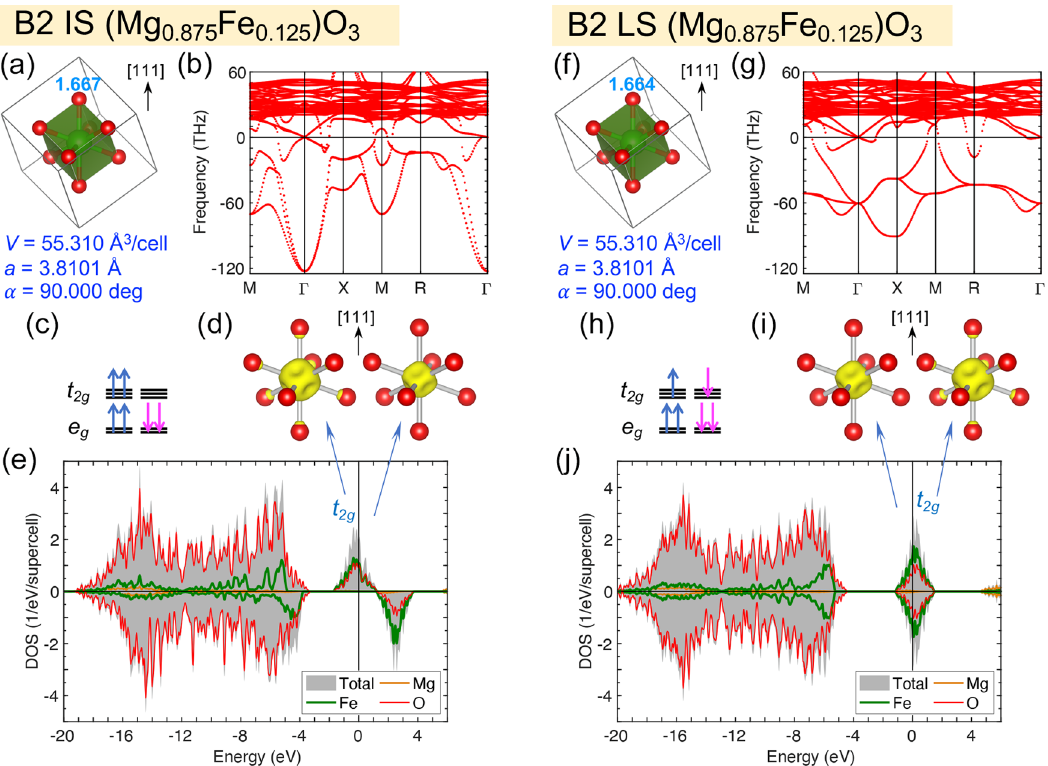
Fig. 3 Atomic structure, stability, and electronic structure of cubic B2 (Mg 0.875 Fe 0.125 )O. Here, the intermediate-spin (IS, a – e ) and low-spin (LS, f – j ) states at volume V = 55.310 Å 3 /cell (6.914 Å 3 /f.u., pressure P ≈ 1.07 TPa) are shown. a , f FeO 8 cubes in the supercell, with the Fe-O bond lengths (in Å ) indicated by the numbers next to the oxygen atoms, and the lattice parameters ( a and α ) listed below; b , g phonon dispersion; c , h orbital occupation; d , i integrated local density of states (ILDOS) of the fi lled and empty t 2 g states; e , j total and projected DOS, with the Fermi energy set as the reference (0 eV). In panels a , d , f , and i , the [111] direction is pointing